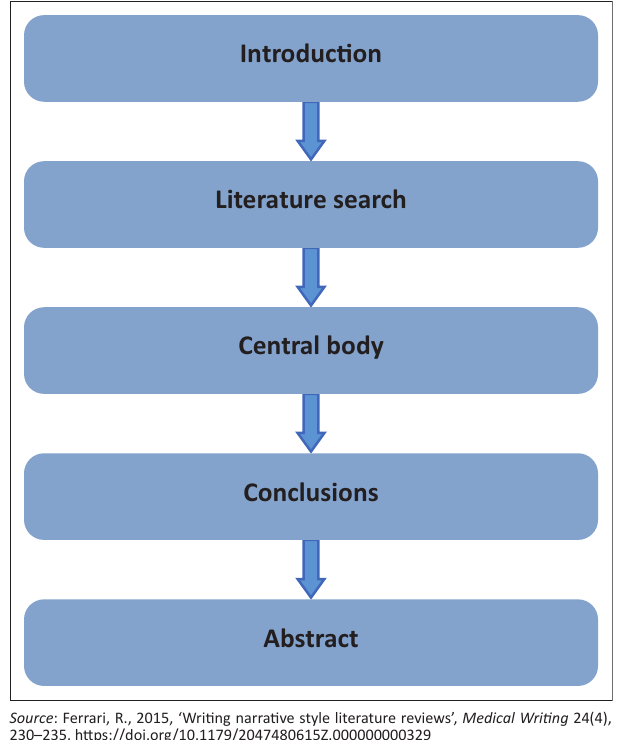
FIGURE 1: Narrative literature review steps as suggested by Ferrari